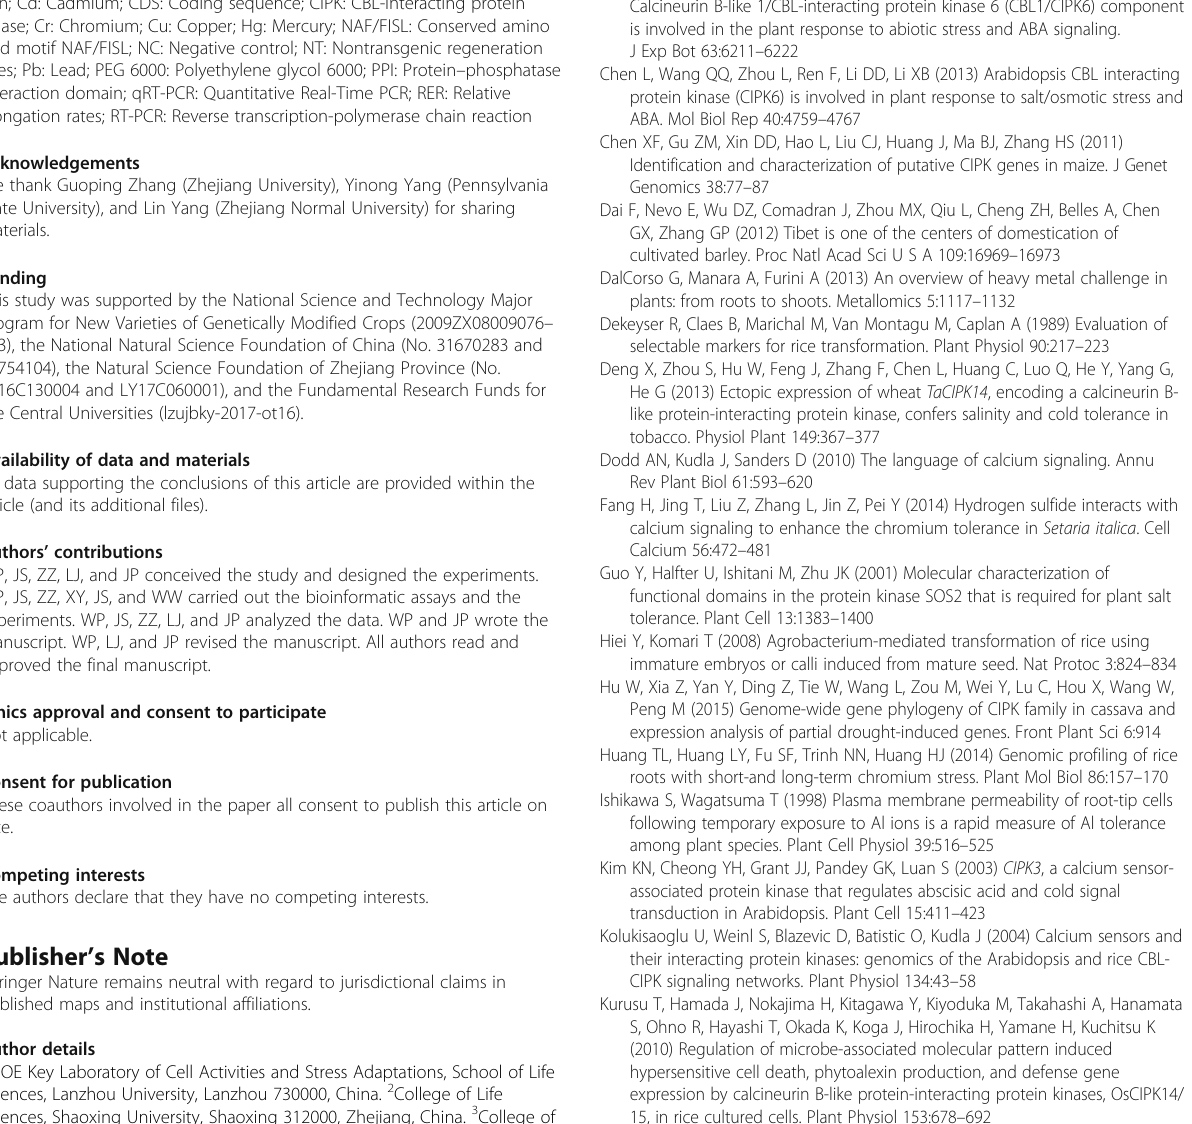
Additional file 1: Figure S1. Effects of abiotic stresses on root elongation in rice. Figure S2. Alignment analysis of amino acid sequences among HsCIPK5, OsCIPK5, and AtCIPK5. Figure S3. GenBank accession numbers and homology analysis of HsCIPKs. Figure S4. Phylogenetic analysis of HsCIPKs, OsCIPKs, and AtCIPKs. Figure S5. Molecular identification of HsCIPK overexpression in rice. Table S1. Accession numbers of rice and Arabidopsis CIPK cDNA in NCBI database. Table S2. Primer sequences for HsCIPKs cloning. Table S3. Primer sequences for qRT-PCR assay in Tibetan Plateau annual wild barley. Table S4. Primer sequences for RT-PCR Assay in rice trans- genic lines. Table S5. Summary of endogenous HsCIPK responses to heavy metal toxicities. Table S6. Summary of endogenous HsCIPK re- sponses to other abiotic stresses. Table S7. Summary of root growth tolerance to abiotic stresses in rice transgenic lines overexpressing HsCIPKs. (PDF 800